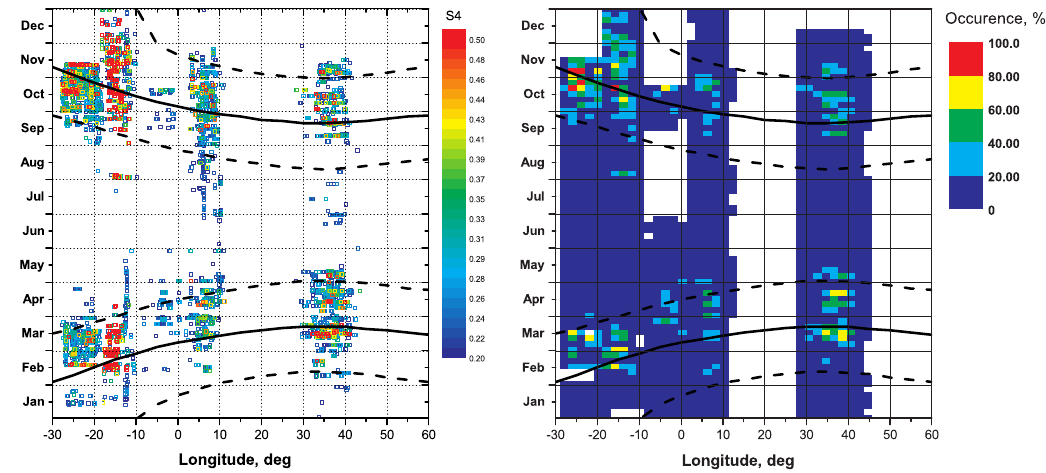
Fig. 4. Left panel: Scintillation intensity as a function of day of the year and longitude. Right panel: Scintillation occurrence rate. On the left panel individual S4 index measurements are shown, while on the right panel, data are binned in 5 degrees × 5 day blocks, for which the occurrence rate is calculated. Black solid lines indicate the region where the solar terminator is aligned with the local geomagnetic field. Black dashed lines indicate regions where this angle is equal to 15 degrees. The strongest and most frequent scintillations occur in the Atlantic region during equinoctial seasons.